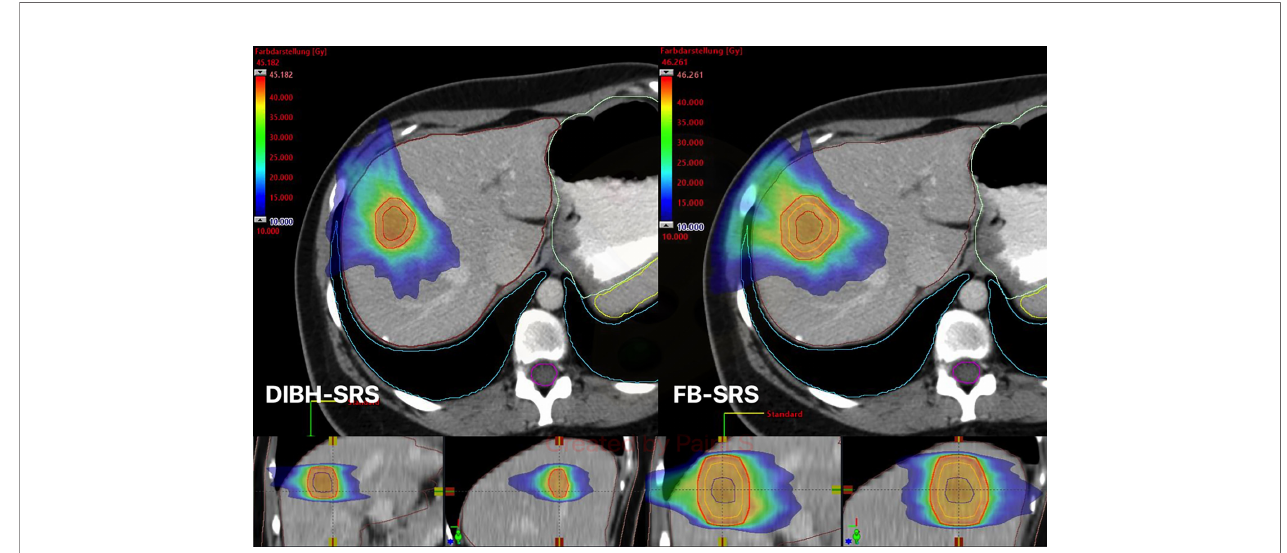
FIGURE 2 | Exemplary case of dose distribution with color wash display for both DIBH-SRS (left) and FB-SRS (right). DIBH, deep inspiration breath hold; SRS, stereotactic radiosurgery; FB, free-breathing; GTV, gross tumor volume (blue line); ITV, internal target volume (orange line); PTV, planning target volume (red